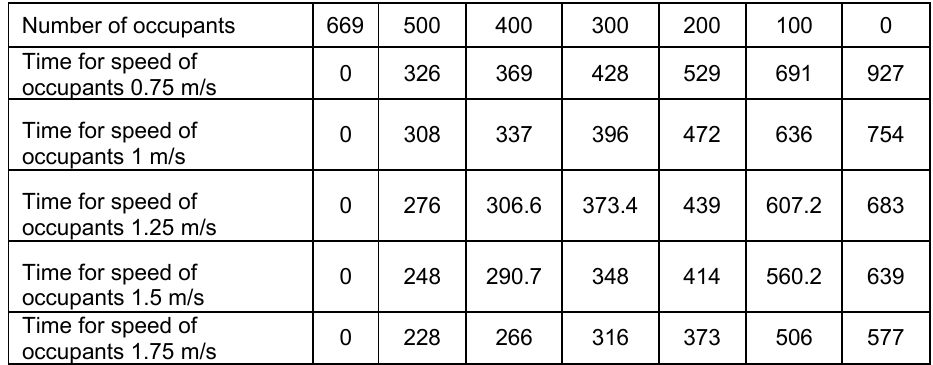
Table 13 – Simulation results in seconds for the third scenario, with elevators enabled and the first and the fourth entrances/exits blocked and for the occupants’ speeds